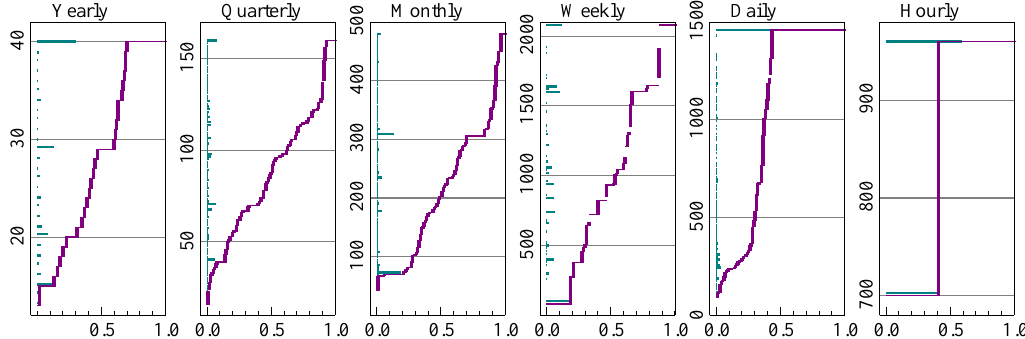
Figure 1. Distribution of sample size after truncation. Truncated at 40 years, except daily at 1500 observations. Along the vertical axis is the bar chart of the frequencies of the different sample